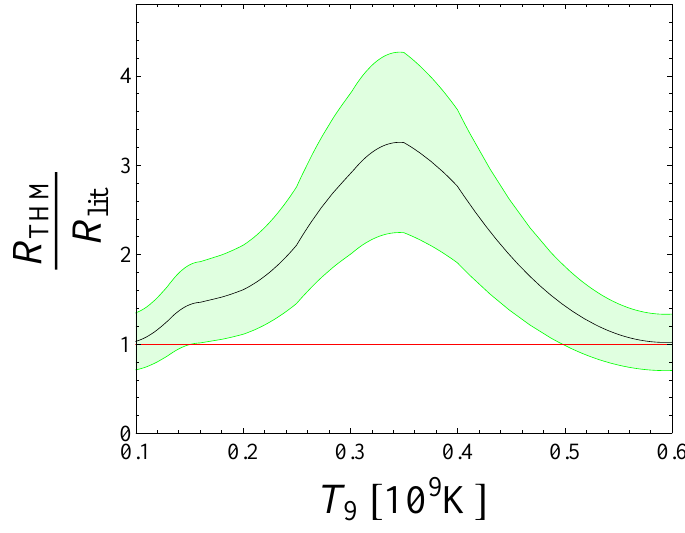
Figure 9. Ratio of the 19 F ( α , p ) 22 Ne THM reaction rate to the one calculated in [113] ( R lit ). The estimated uncertainties of the THM data are reported as a green band (see [114] for